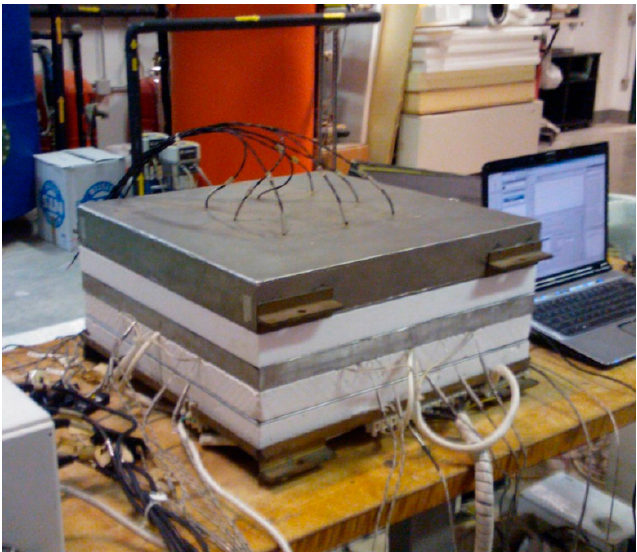
Figure 4. Sample during the hot-plate analysis. Table 3. Thermal conductivity measurements of the HP 1-PCM 3% sample at different